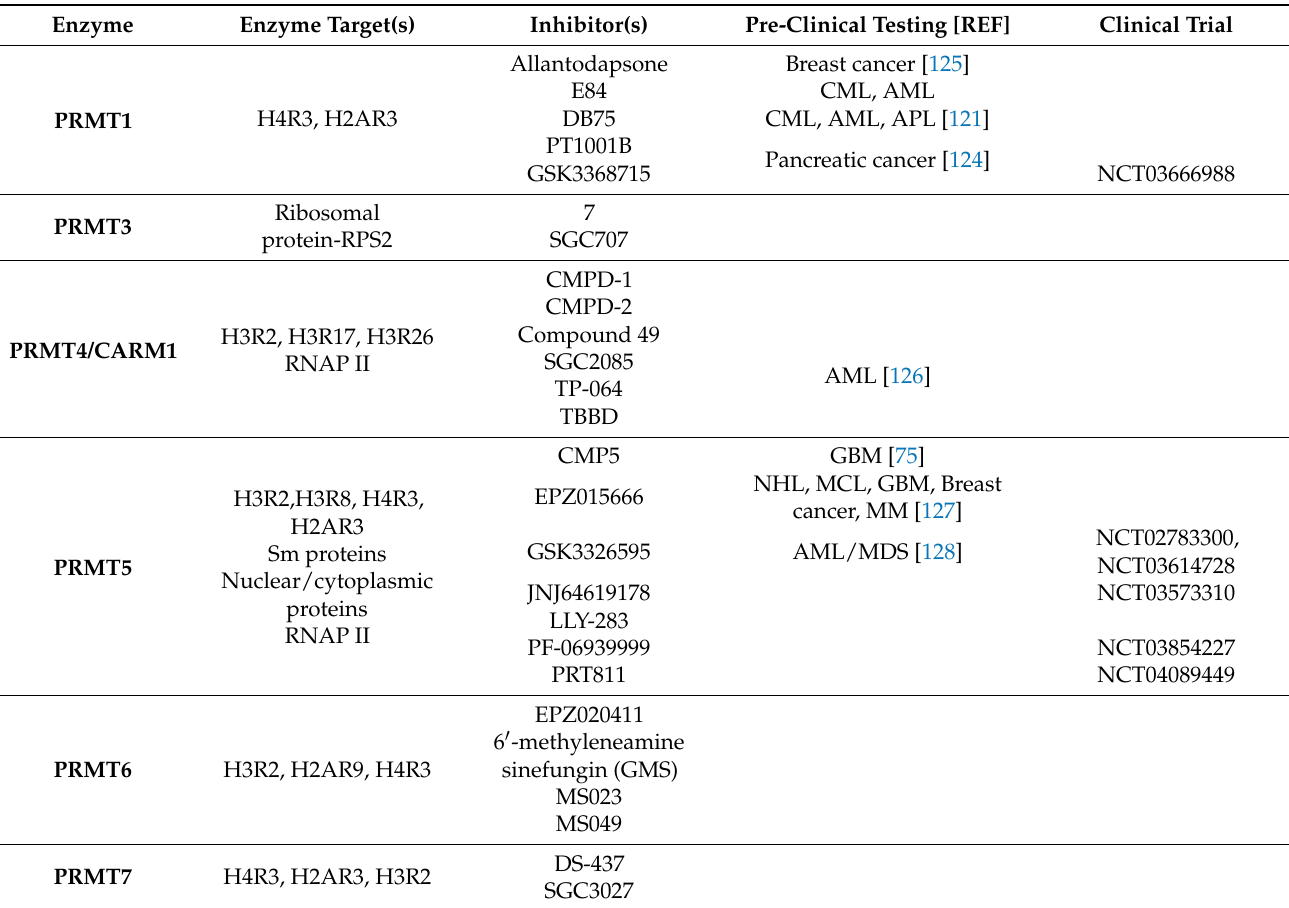
Table 2. Small molecule inhibitors of PRMT enzymes. CML = Chronic myeloid leukemia; NSCLC = Non-small cell lung carcinoma; GBM = Glioblastoma; MCL = Mantle cell lymphoma; DLBCL = Diffuse large B-cell lymphoma; NHL = Non-Hodgkin lymphoma; MM = Multiple myeloma; AML = Acute myeloid leukemia; APL = Acute promyelo- cytic